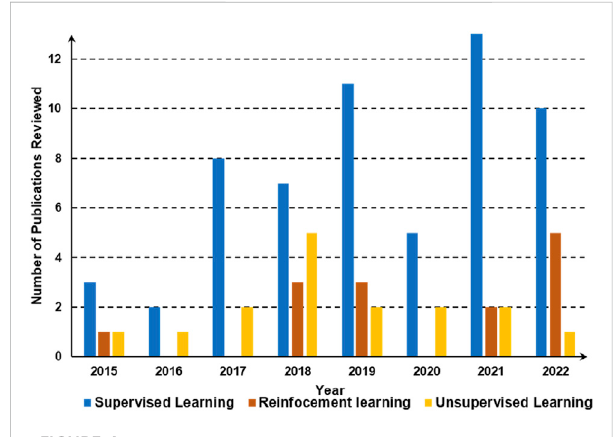
FIGURE 4 Number of publications of learning algorithms for intelligent grasping in recent